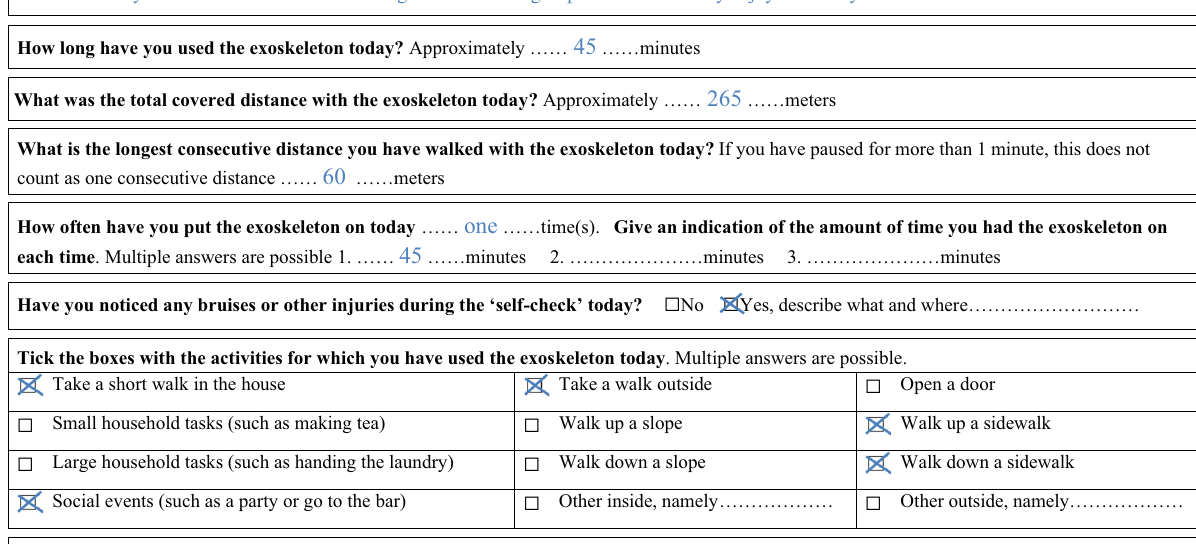
Figure 1. Example of the logbook during the period of home and community